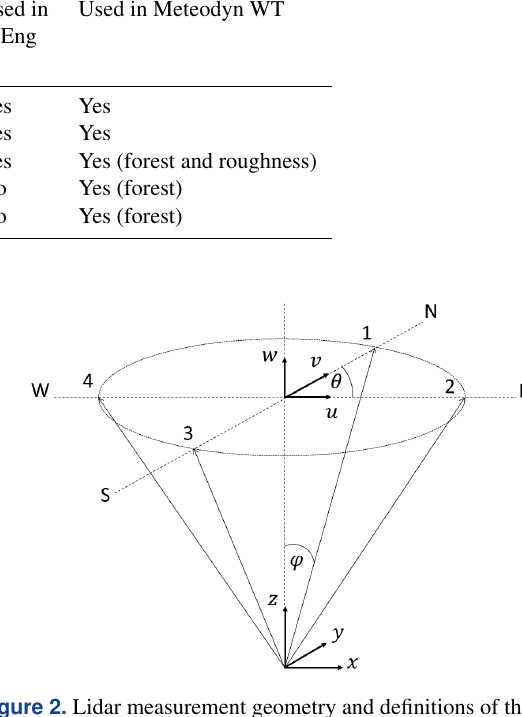
Figure 2. Lidar measurement geometry and definitions of the local coordinate system ( x , y , z ) and the wind vector components ( u , v , w ) as well as the half-cone opening angle ϕ and the azimuth angle θ (here for the second measurement location, 90 ◦ from the north). The measurement locations are numbered starting from north (N) clock-wise to west (W). The measurement locations are shown for an example measurement height at a plane defined by the circle. This measurement geometry equals the one that is used in the Leo- sphere WindCube v1. In the successive version WindCube v2, a fifth measurement location has been added with ϕ = 0 directly above the origin at measurement